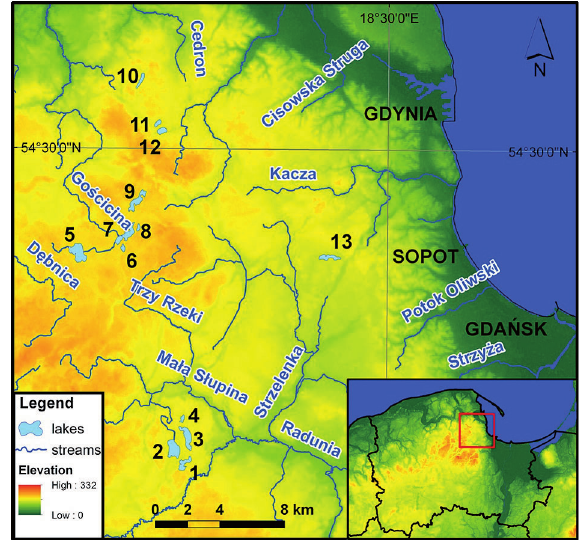
Fig. 2. Location of analysed lakes 1 – Karlikowskie; 2 – Sitno; 3 – Głębokie; 4 – Techlinko; 5 –